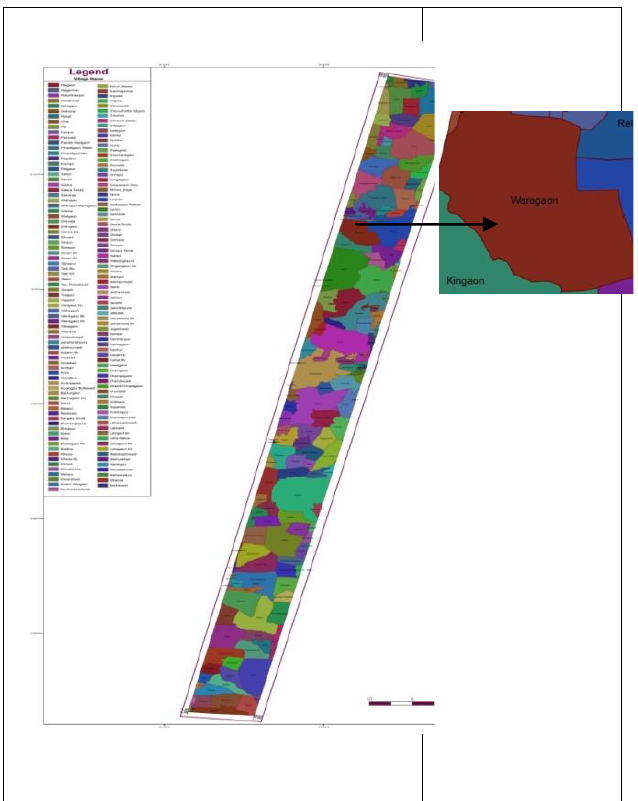
Figure 2: Study area